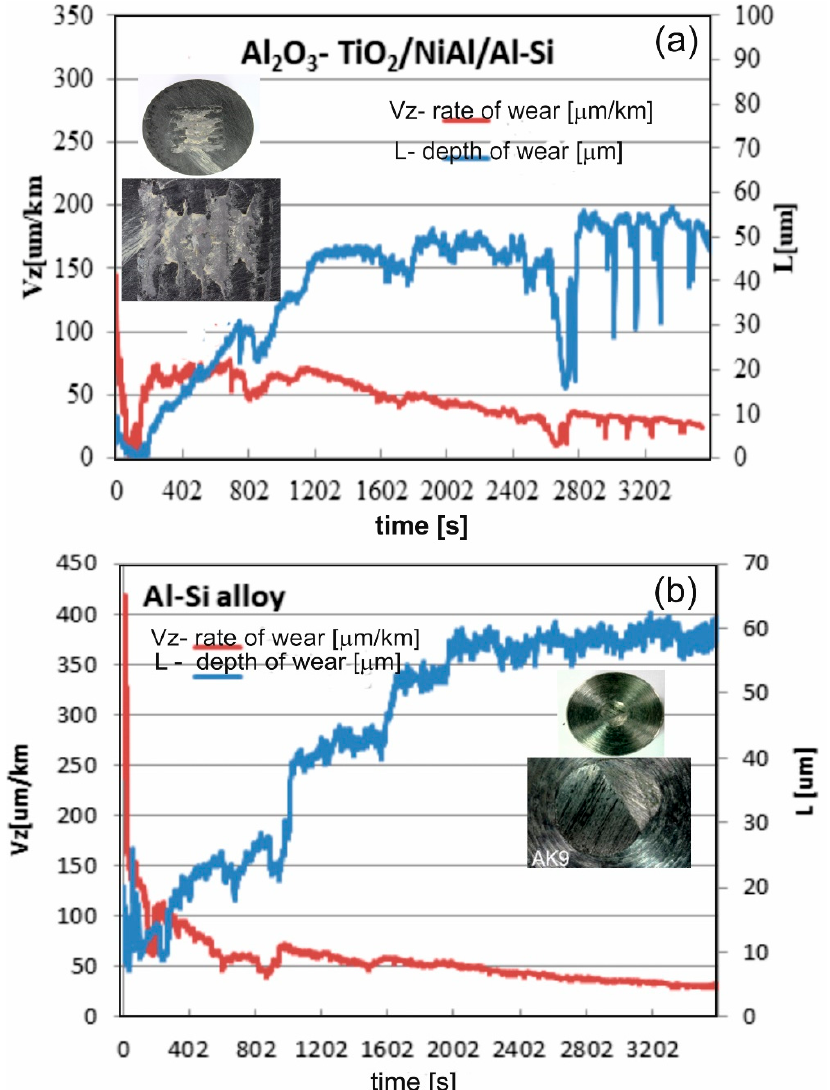
Figure 13. The results of the erosion resistance tests of: ( a ) the Al 2 O 3 -15 wt.%TiO 2 /NiAl/Al-Si coating system, ( b ) Al-Si cast alloy.